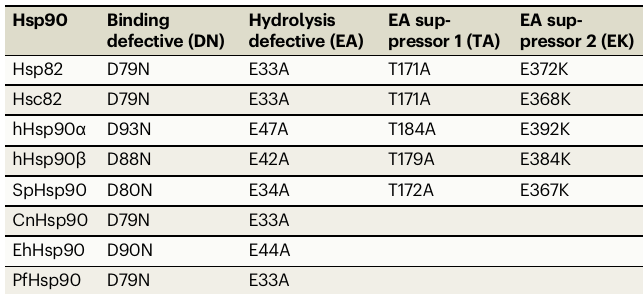
Table 3 | Amino acid positions of mutants by Hsp90 ortholog